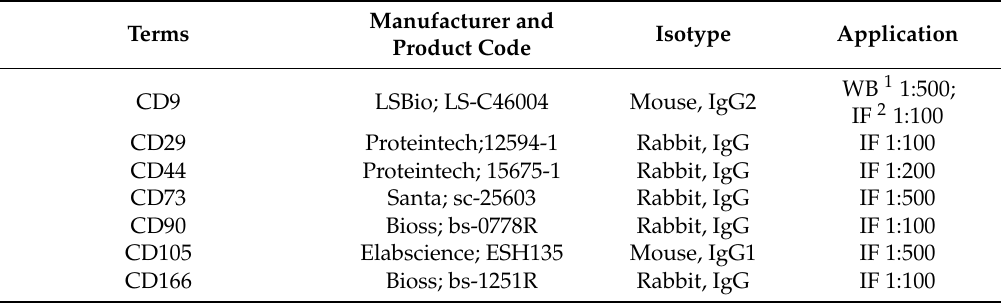
Table 4. Antibodies used in this